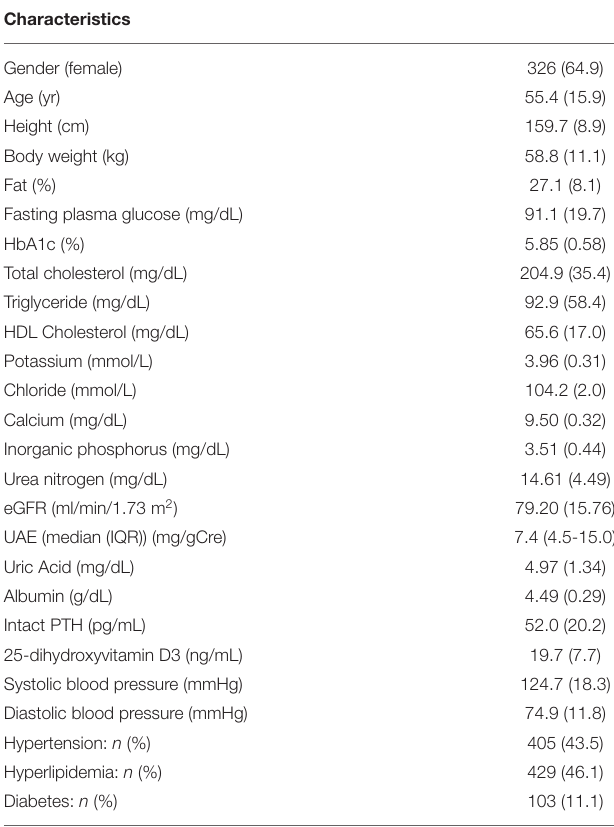
TABLE 1 | Clinical characteristics of the